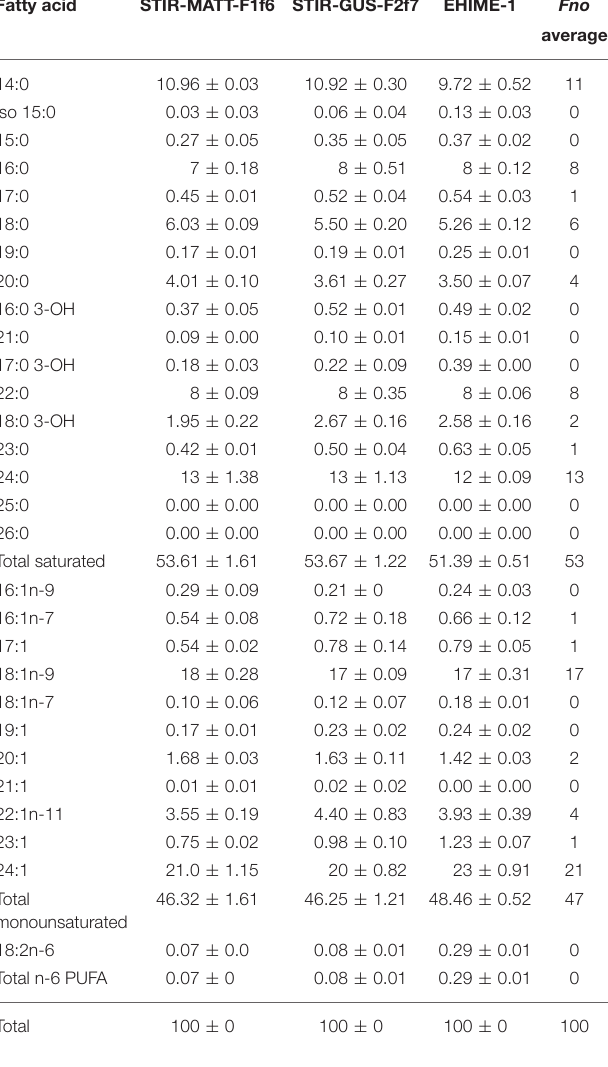
Fatty acid STIR-MATT-F1f6 STIR-GUS-F2f7 EHIME-1 Fno